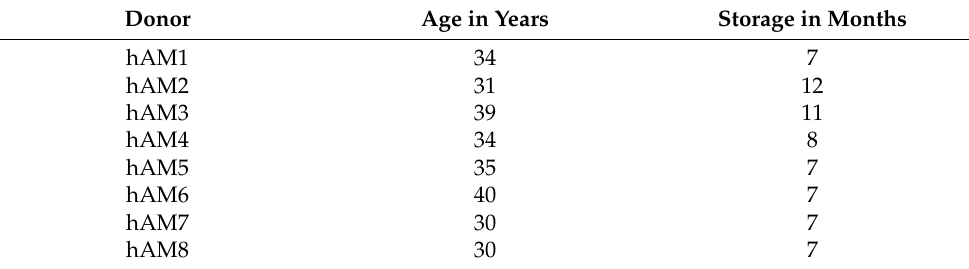
Table 1. Donor age and storage time of hAM